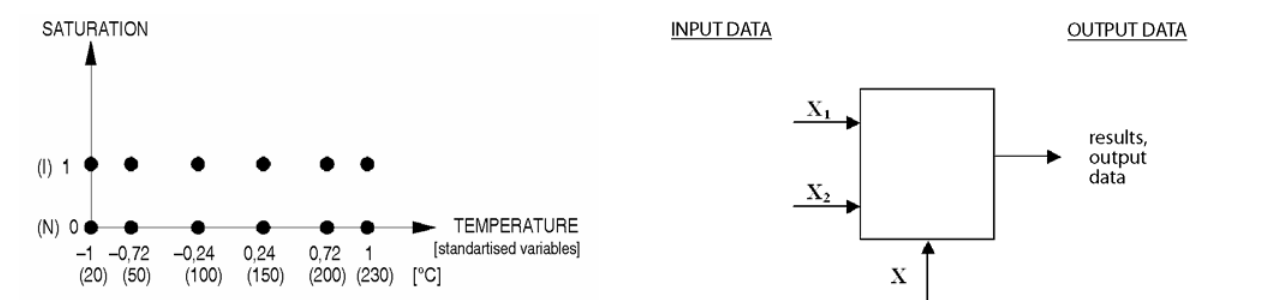
constant factors: wood species, moisture content, X1 – va- riable factors – saturation status: saturated = 1, non- saturated = 0, water-saturated = –1, X2 – variable factor: temperature of thermal treatment before tests. Output da- ta: dynamic strength